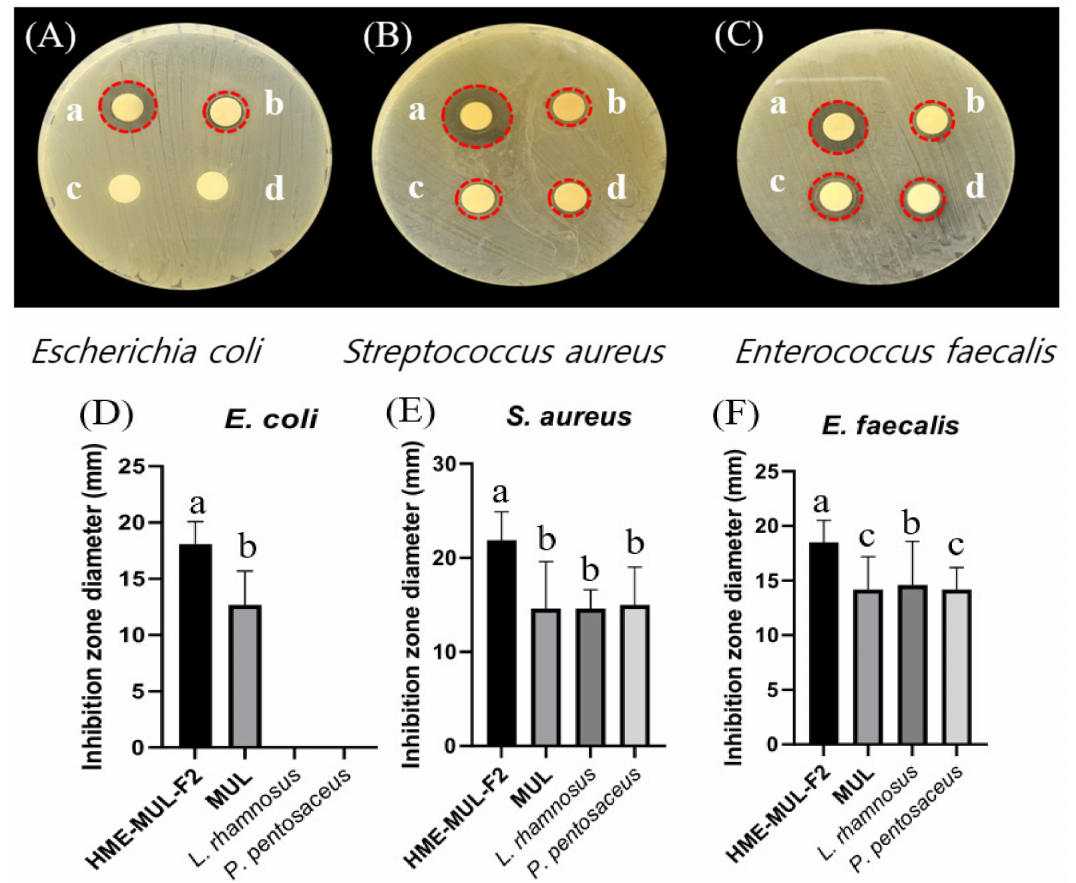
Figure 6. Inhibition zones in the presence of probiotics ( L. rhamnosus and P. pentosaceus ), mulberry raw materials (MUL), and HME-DDS formulation (HME-MUL-F2). ( A , D ): inhibition zone of E. coli . ( B , E ): inhibition zone of S. aureus . ( C , F ): inhibition zone of E. faecalis . a: treatment with HME-MUL-F2; b: treatment with MUL; c: treatment with L. rhamnosus ; d: treatment with P. pentosaceus . ( A – C ): photo of clear zone after treatment with probiotics, HME-MUL-F2, and MUL. ( D – F ): quantification of inhibition zone diameter after treatment with probiotics, HME-MUL-F2, or MUL. a,b value